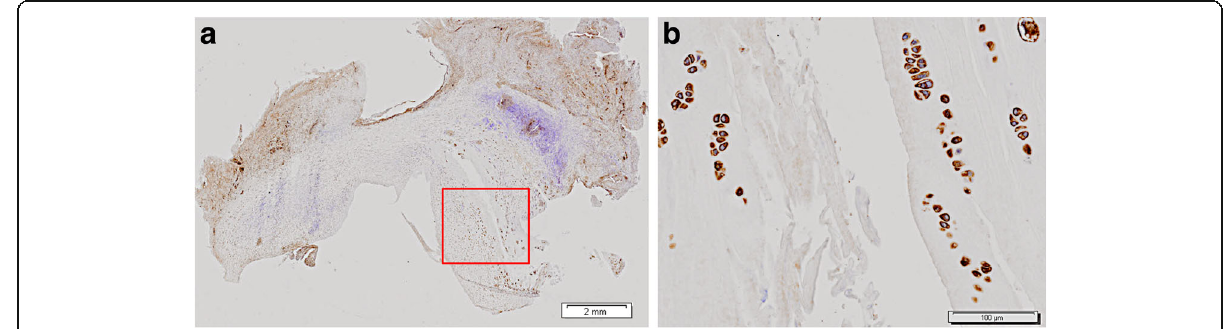
Fig. 3 Cell clusters, COMP immunohistochemistry. a Microphotograph of a COMP stained medial meniscus 12 weeks after ACL-transection, where a tear can be seen. b 100×. Cell clusters, showing chondrocyte-like cells, strongly stain for COMP around the meniscal tear from the boxed area in ( a